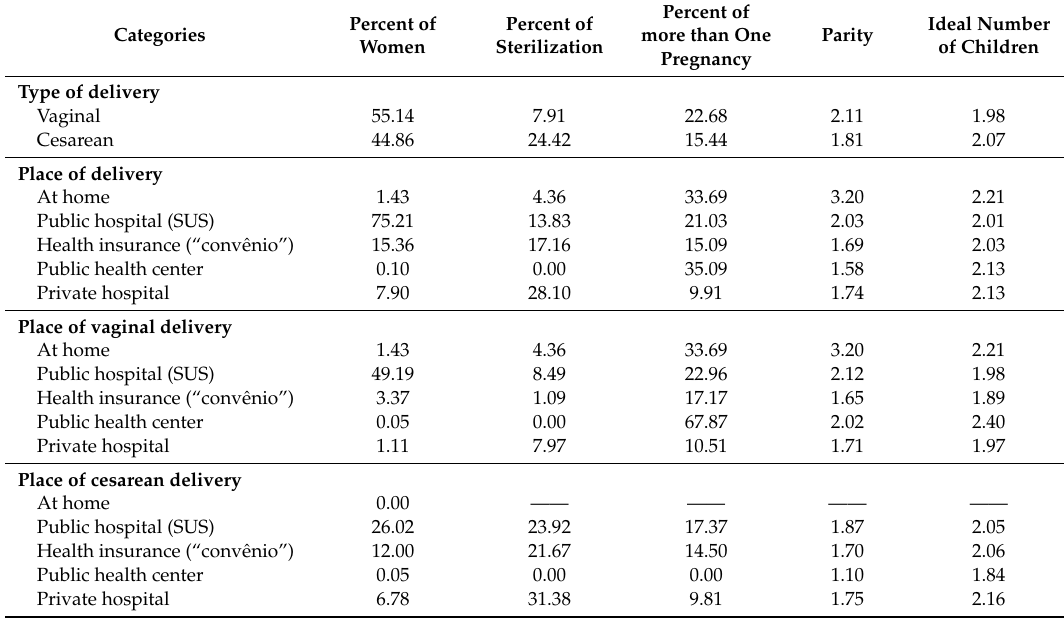
Table 2. Distribution of women by type and place of delivery, Brazil, January 2001 to July